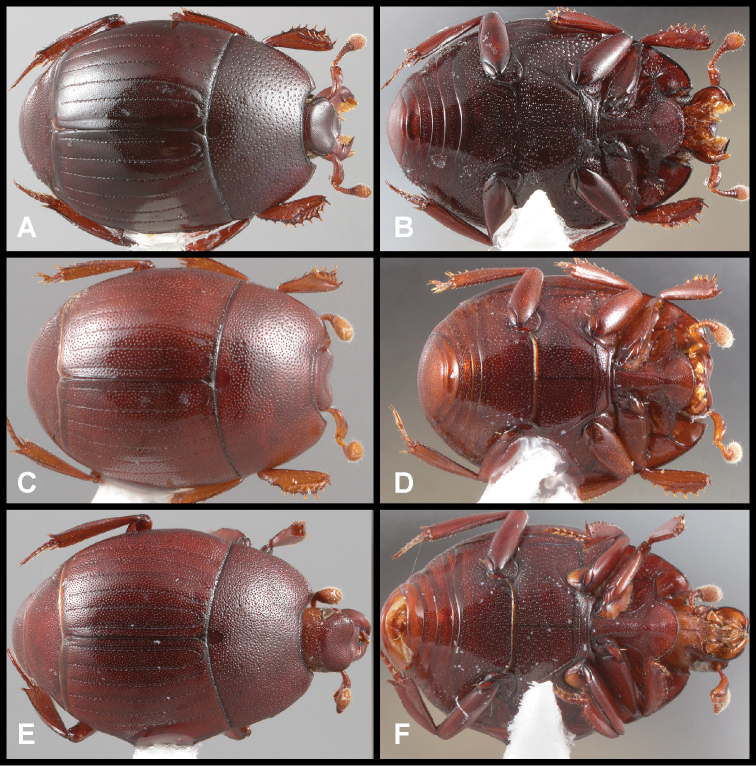
A, BPhelister
incongruens: A dorsal habitus B ventral habitus C, DP.
congruens: C dorsal habitus D ventral habitus E, FP.
praesignis: E dorsal habitus F ventral habitus.